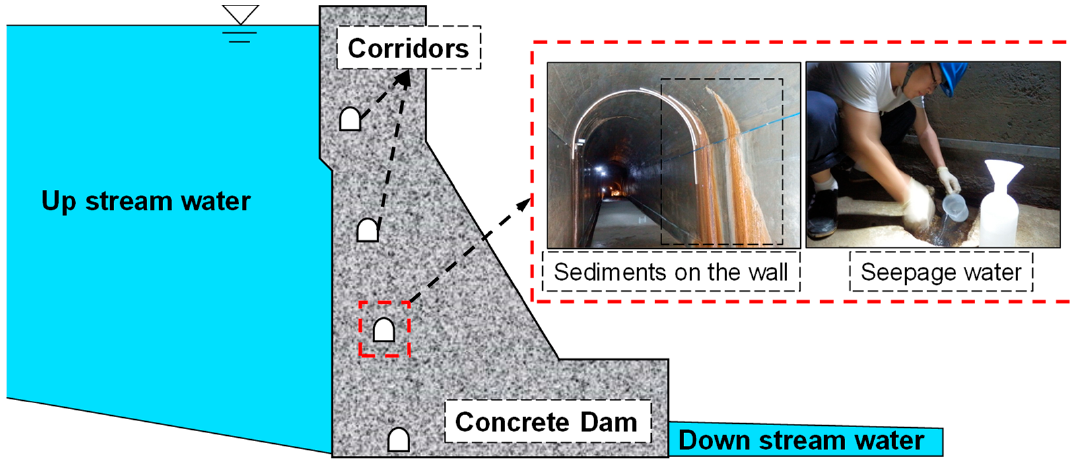
Figure 3. The experimental and simulated profiles of calcium distribution.